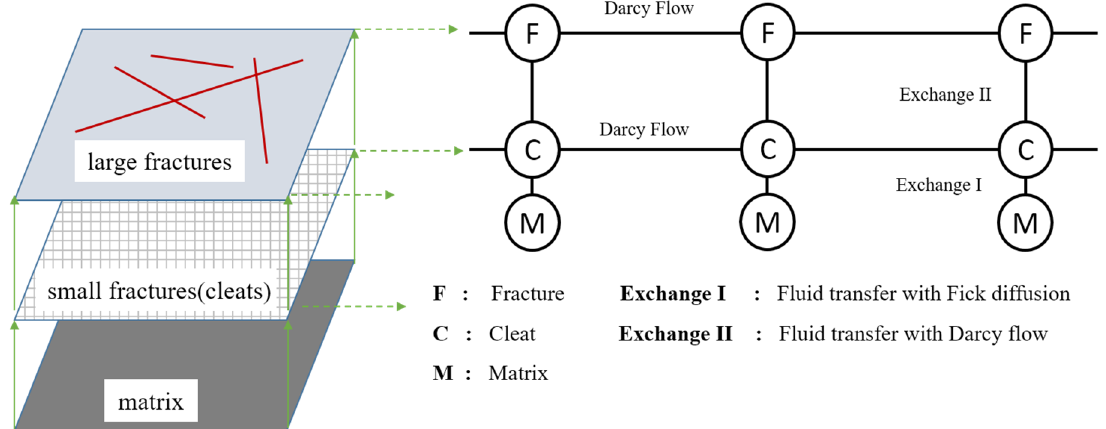
Figure 2. Schematically shown the new reservoir characterization with